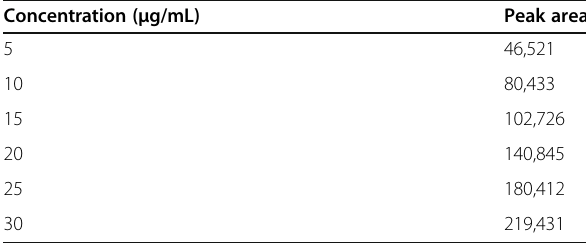
Table 5 Linearity of